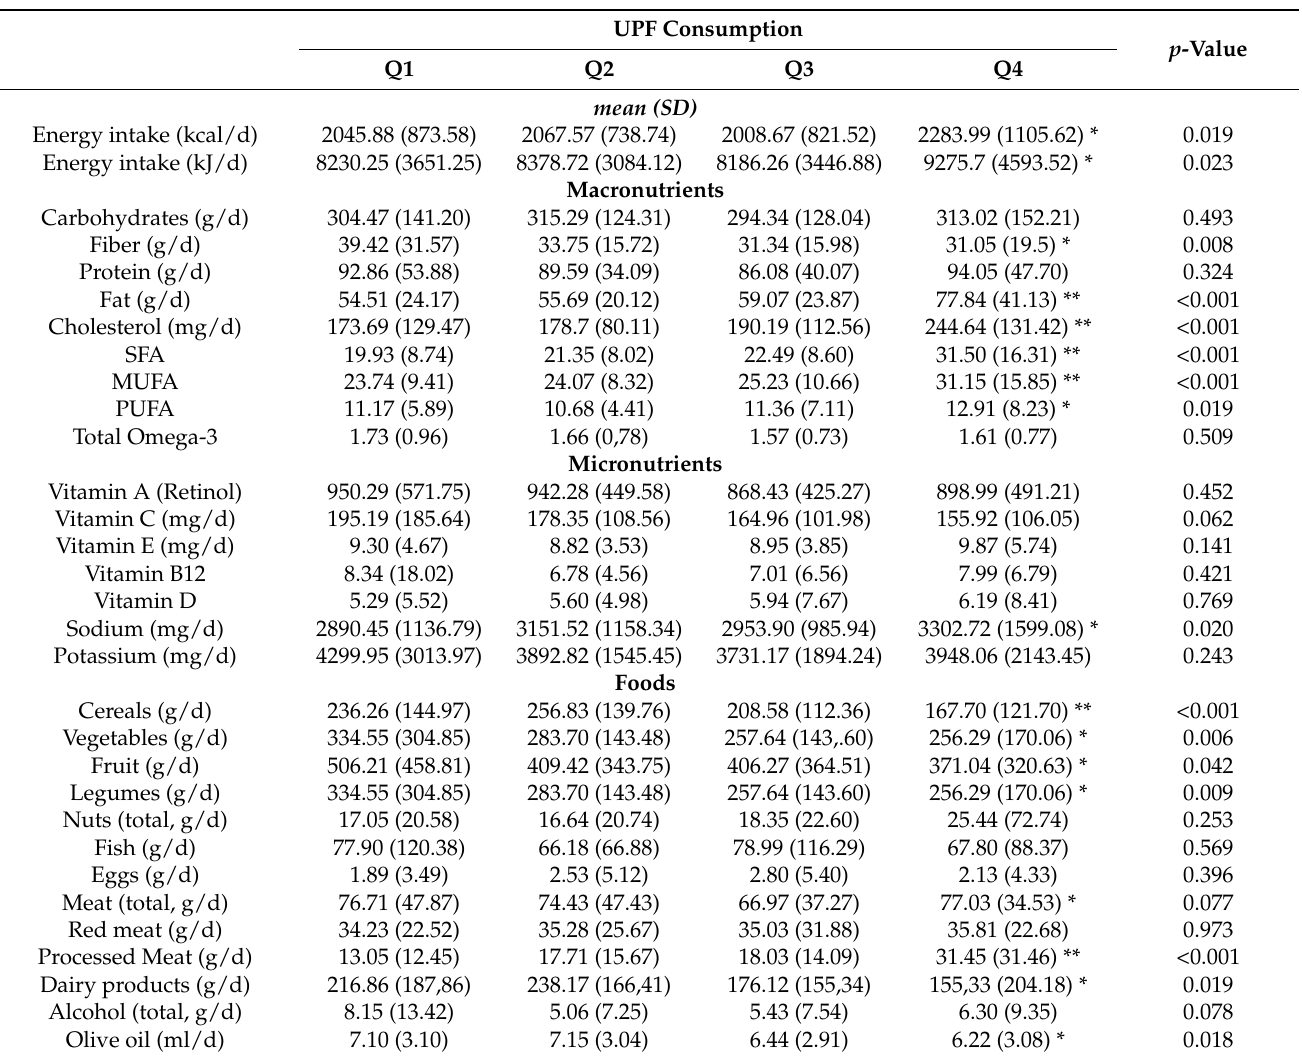
Table 2. Mean (and standard deviation) consumption of micro-, macronutrients and major food groups intake according to quartiles of UFP consumption. UPF